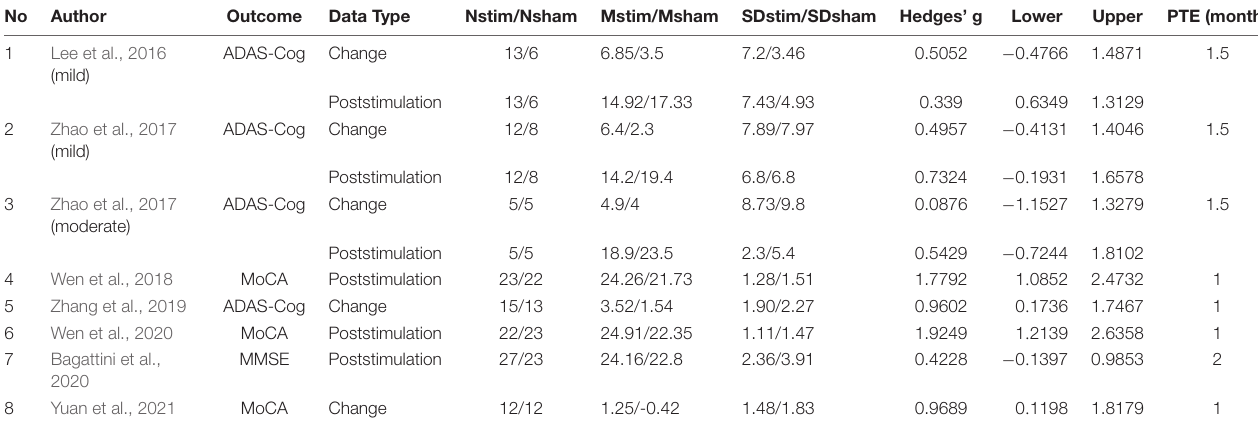
TABLE 5 | Summary of the effect sizes for global cognitive function of the post-treatment assessments.